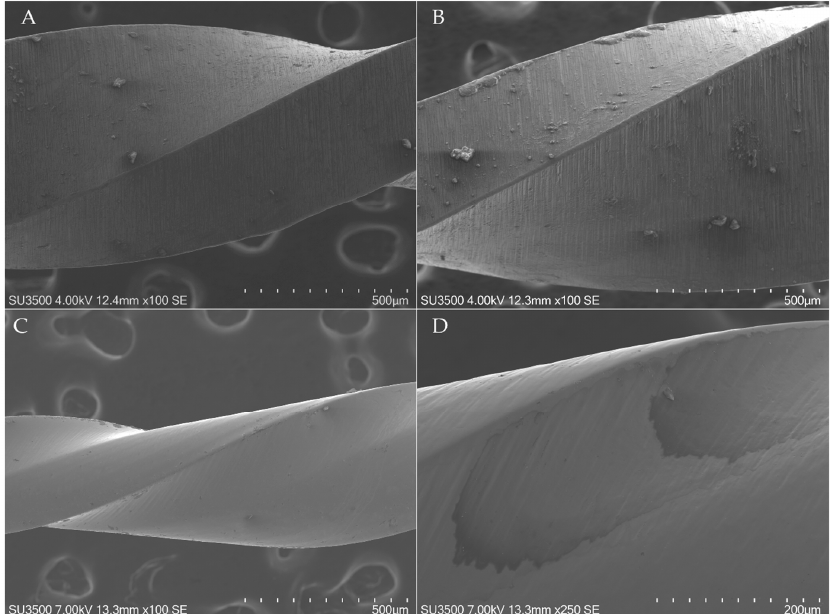
Figure 3. SEM images of debris on instruments surface. ( A , B ) EOF instruments, in which are shown several debris on the entire surface of the instrument. ( C ) OR instrument, in which are shown sporadic debris on the surface. ( D ) OR instrument, in which is shown an oily spot on the surface. All WOG instruments showed a disruption of cutting edges for their entire length, maintained also after the shaping procedures (incidence of 10) (Figure 4). Those alterations did not act as points of least resistance for the development of microfractures. Moreover, the limited flattening of the cutting edges arising from simulated clinical use leads to a consequent reduction of cutting-edge disruption. It can be speculated that those morphological aspects arise from the machining procedures and do not have any role in the microcracks and fracture propagation.